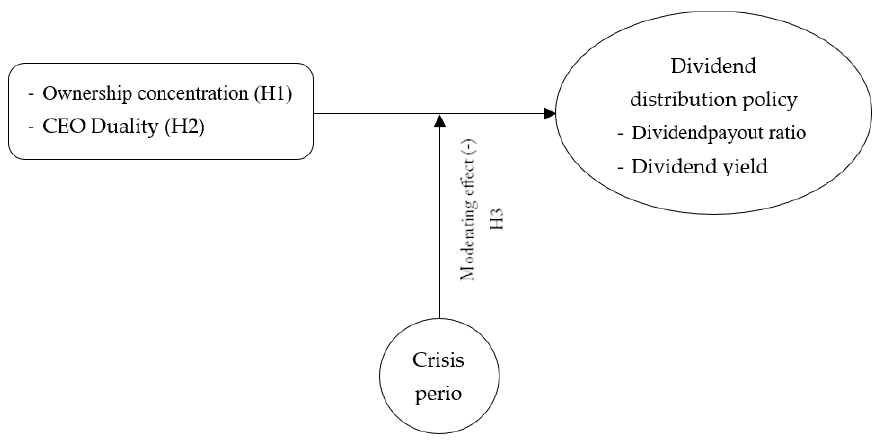
Figure 1. Conceptual framework.